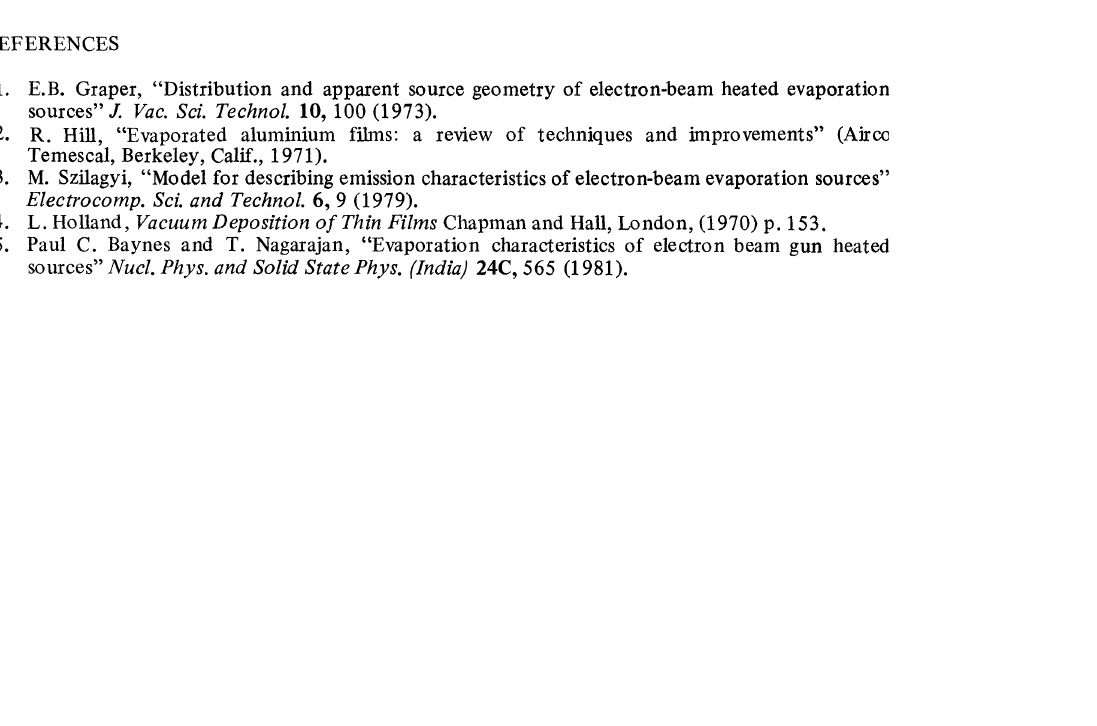
O.OC 0O(3 I.(0 FIGURE 8 Polar Plot of the evaporation characteristics for a cylindrical